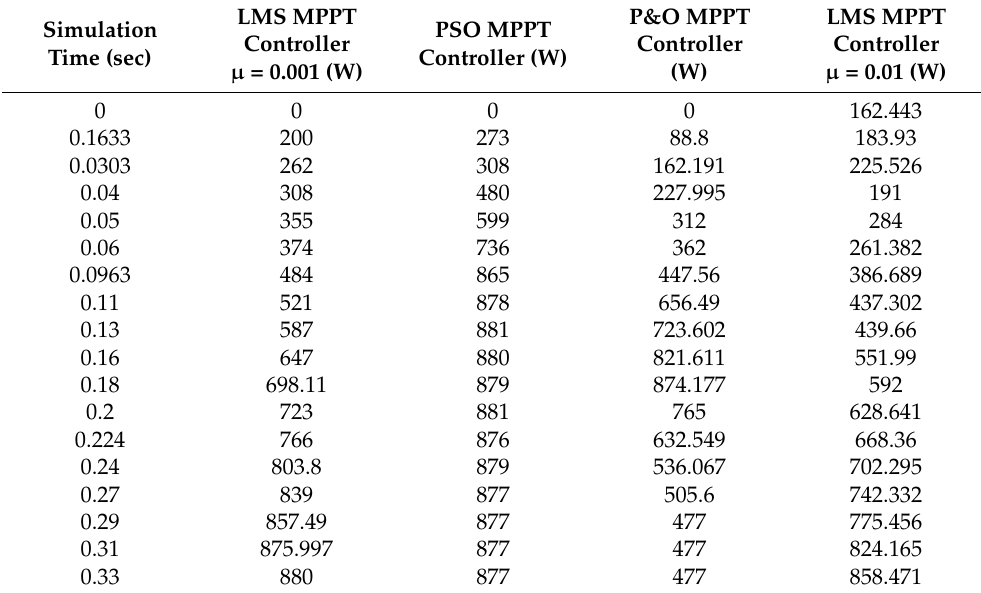
Table 9. Solar panel output power (W) by three MPPT controllers.